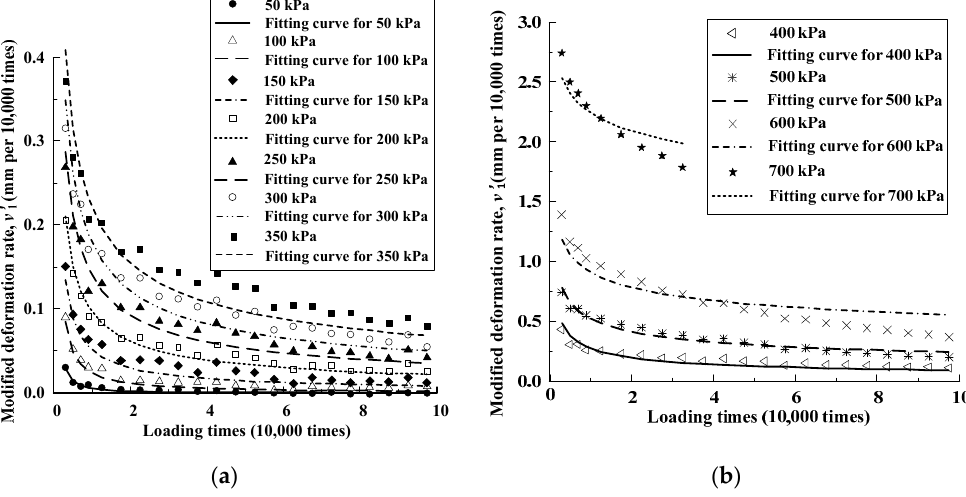
Figure 14. The relationship between modified deformation rate and loading times for Model 3 (K = 1.0) when cyclic amplitude ranges from ( a ) 50 kPa to 350 kPa; ( b ) 400 kPa to 700 kPa.